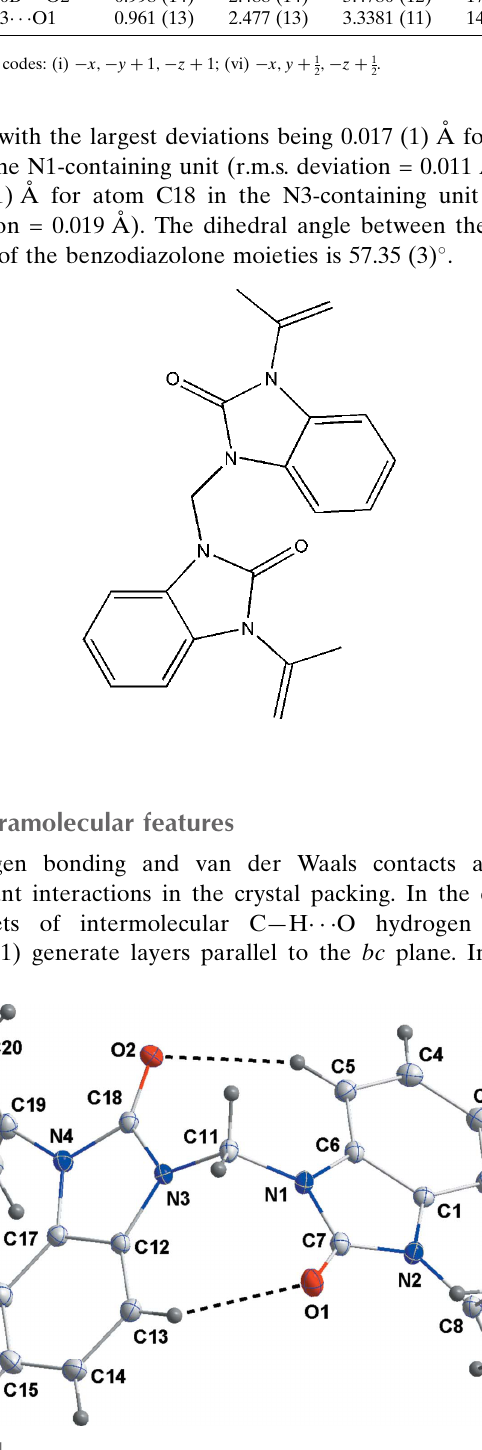
Figure 3 View of the three-dimensional Hirshfeld surface of the title compound plotted over d norm in the range (cid:5) 0.1476 to 1.2686